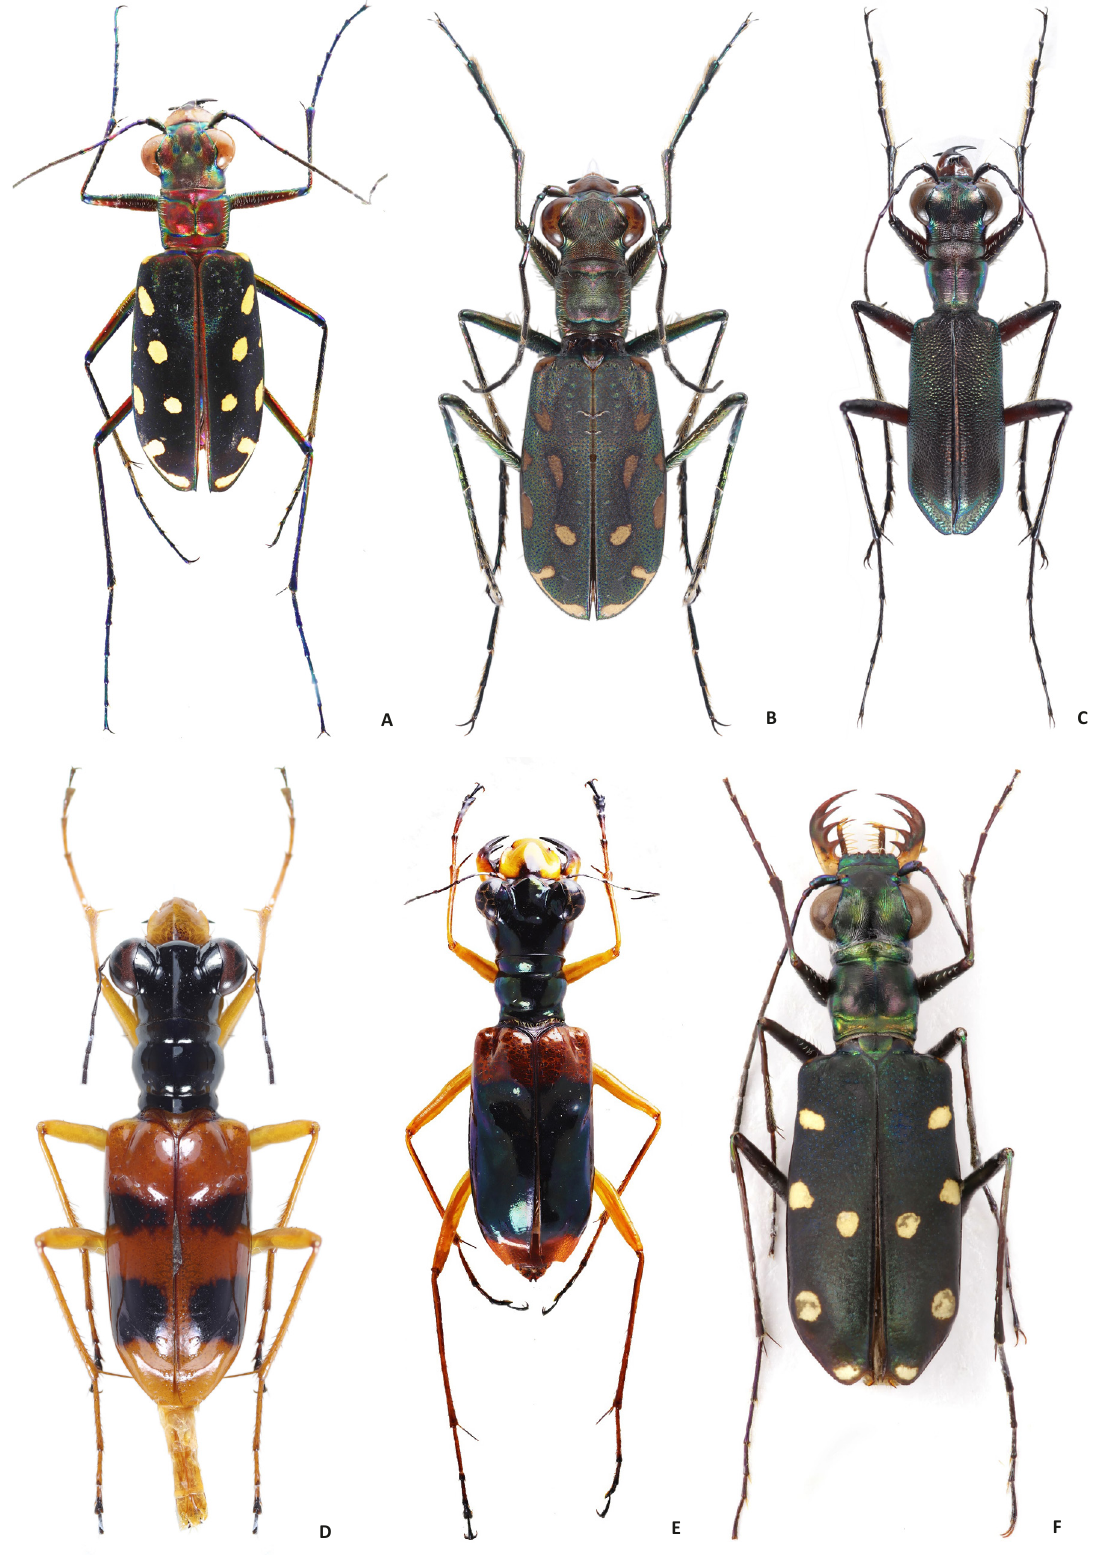
Image 1. Tiger beetles in Davao region: A— Calomera mindanaoensis (Cassola, 2000) | B— Calomera lacrymosa (Dejean, 1825) | C - Heptodonta lumawigi (Wiesner, 1980) | D — Therates fasciatus quadrimaculatus Horn 1895 | E— Therates fulvipennis everetti (Bates 1878) | F— Thopeutica petertaylori (Medina, Cabras, Wiesner, 2019). © A,D - H. Ramillano | B,C,E - C. Torrejos & R. Cabras | F - J.